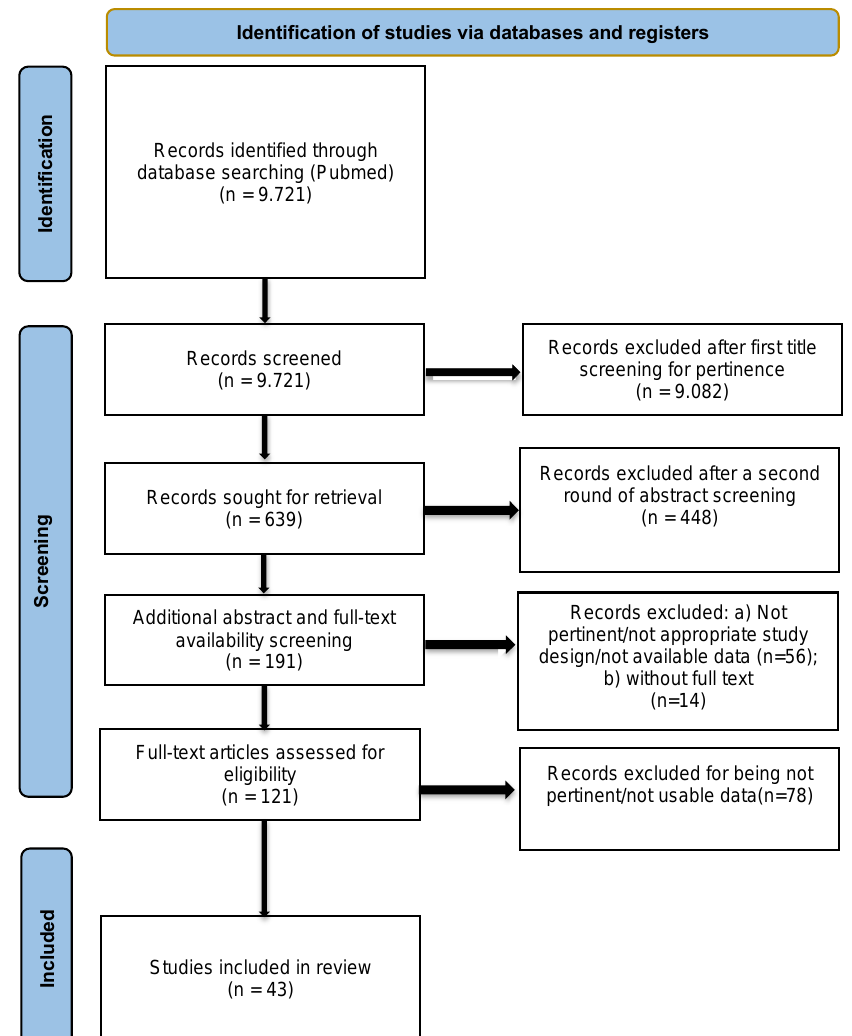
Figure 1. Flow chart of the study selection process.